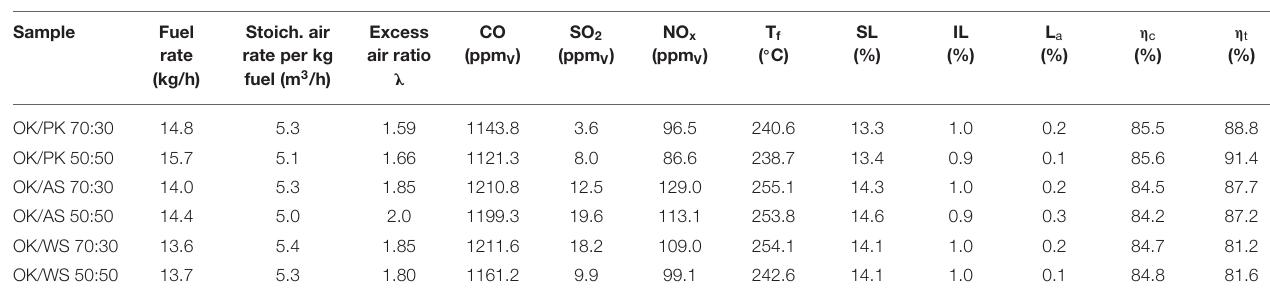
TABLE 4 | Combustion characteristics of fuel mixtures (average values) at steady state.